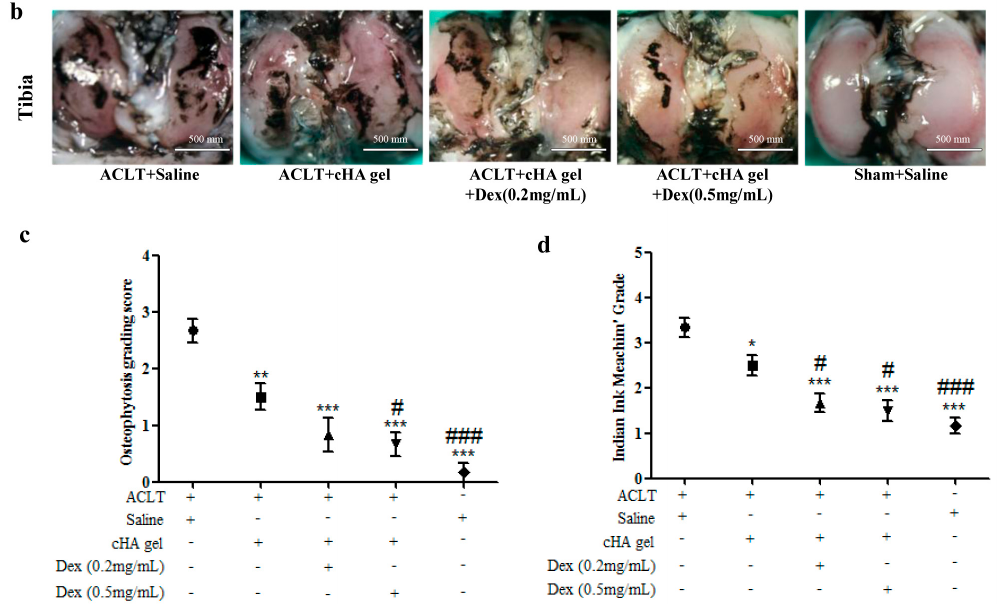
Figure 2. Intra-articular cross-linked hyaluronic acid-dexamethasone (cHA-Dex) hydrogel injection attenuated osteoarthritis (OA) macroscopically. Following anterior cruciate ligament transection (ACLT) surgical induction of OA, micro X-Ray ( a ) was used to evaluate the severity of OA in the right knee before the animals were euthanized; ( b ) Gross morphological cartilage lesion and fibrillation in the rat tibial plateau were visualized by Indian ink staining; ( c ) Radiographic osteophytosis was graded subjectively on a scale from 0 to 3 (0-normal, 1-mild, 2-moderate, 3-severe) based on the severity of osteophytosis at the margins of the knee joint; ( d ) Cartilage lesions and fibrillation was quantified using the Meachim grading system. Data were expressed as means ± SD. *, compared with ACLT + saline group, designated as * p < 0.05, ** p < 0.01 and *** p < 0.001; #, compared with ACLT + cHA gel group, designated as # p < 0.05, and ### p < 0.001. n = 10.